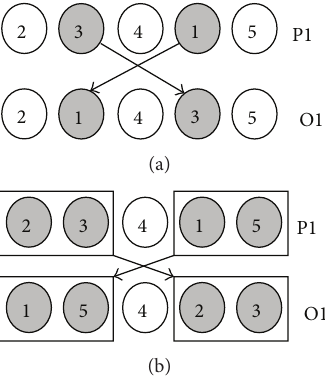
Figure 3: (a) Allele swapping (ASO) and (b) block swapping (BSO) mutation